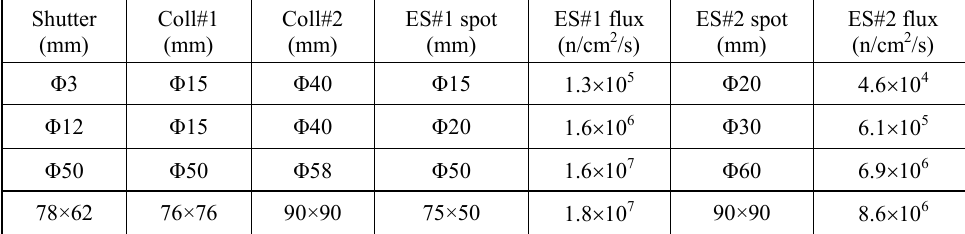
Fig. 1 Back-n white neutron beam line and spectrometers Table 1. Different sets of beam spots, collimator apertures and neutron fluxes at Back-n at 100 kW in proton beam power. Except the first set which is for reducing fluxes, all the other aperture sets have been optimized according to the definition of the beam spot sizes at